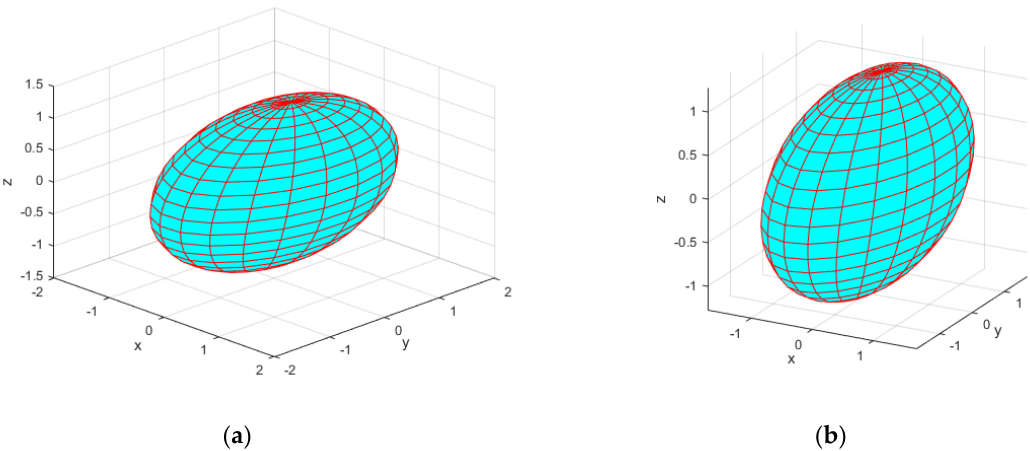
Figure 16. The EE velocity ellipsoid with d 1 = 0.3 and q 2 = q 3 = q ellipsoid; ( b ) rotational velocity ellipsoid.